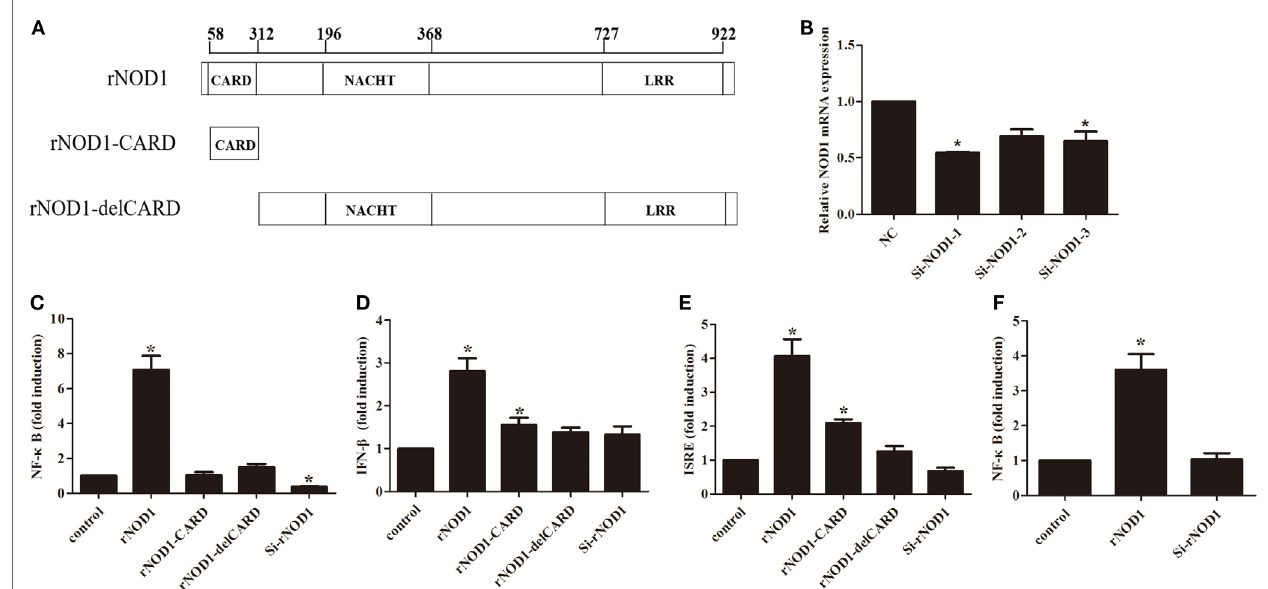
FigUre 3 | Effects of nuclear factor- κ B (NF- κ B), interferon (IFN- β ), and ISRE on different rabbit nucleotide-binding oligomerization domain 1 (rNOD1) domains and si-NOD1. (a) Domains used to construct pC-rNOD1, pC-rNOD1-CARD, and pC-rNOD1-delCARD plasmids. (B) Silencing efficiency of siRNA targeting rNOD1. RK-13 cells were transfected with siRNA1, 2, or 3 for 24 h and NOD1 expression was analyzed. NC siRNA was used as a control. Gapdh was used as the internal control. pC-rNOD1, pC-rNOD1-CARD, pC-rNOD1-delCARD, or pCDNA3.1-empty or with si-rNOD1 or NC siRNA with (c) NF- κ B, (D) IFN- β , and (e) ISRE reporter plasmid, and pRL-TK plasmid were transfected into cells for 24 h. (F) After 24 h of cotransfection with NF- κ B, the cells were infected with Escherichia coli . M ± SD from three independent experiments are presented. Significant differences are indicated by